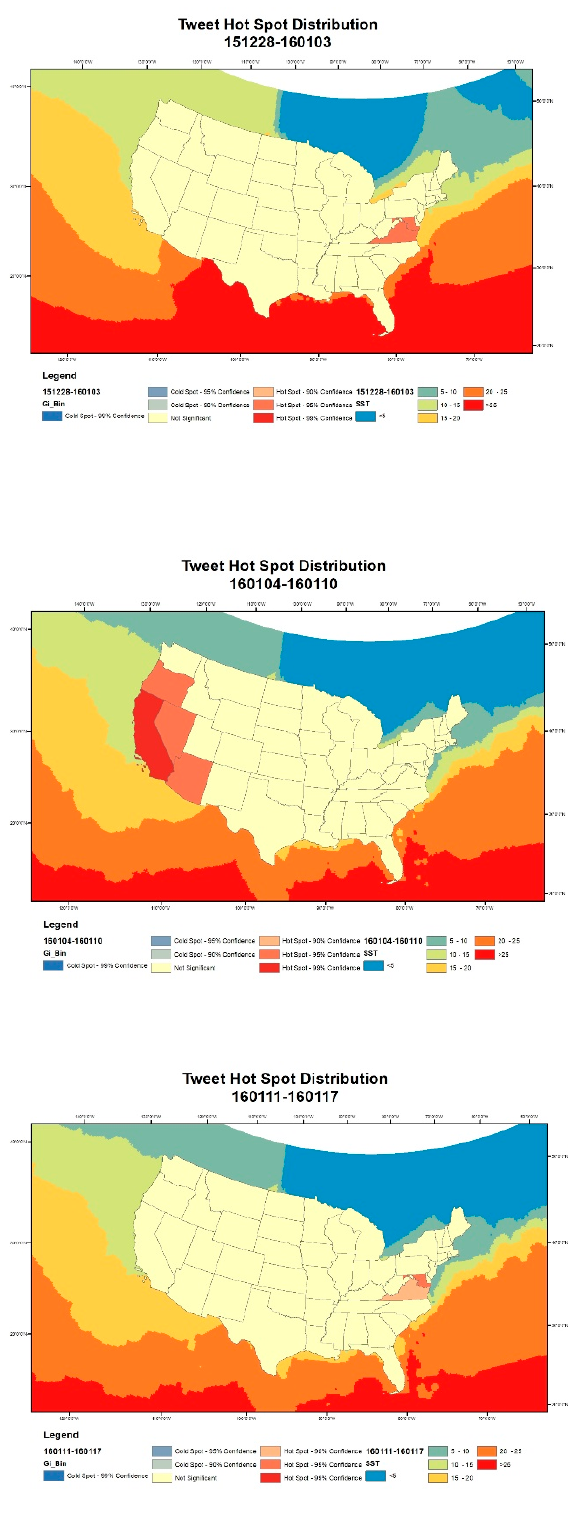
Figure 12. Spatial–temporal variation of Twitter point before, during and after the CA storm.